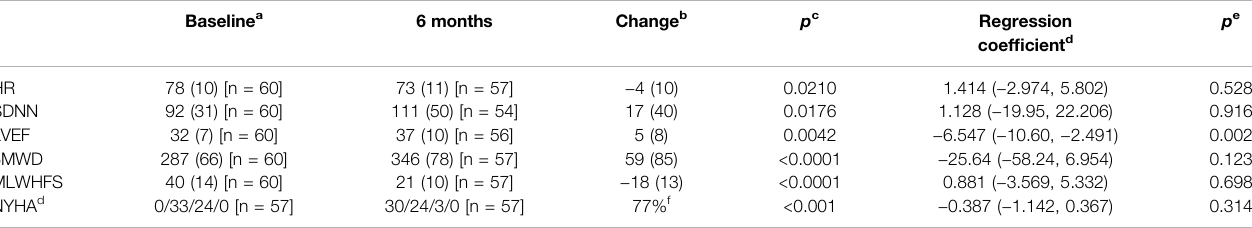
TABLE 7 | Repeated measures analysis of changes associated with VNS in the ANTHEM-HF Pilot Study and relationship to baseline NT-proBNP value.